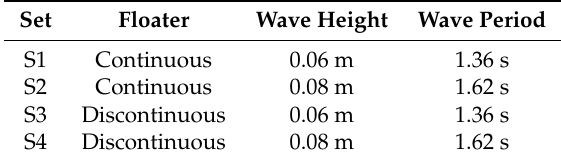
Table 1. Parameters for the four sets of experiments on the flexible floater device. Set